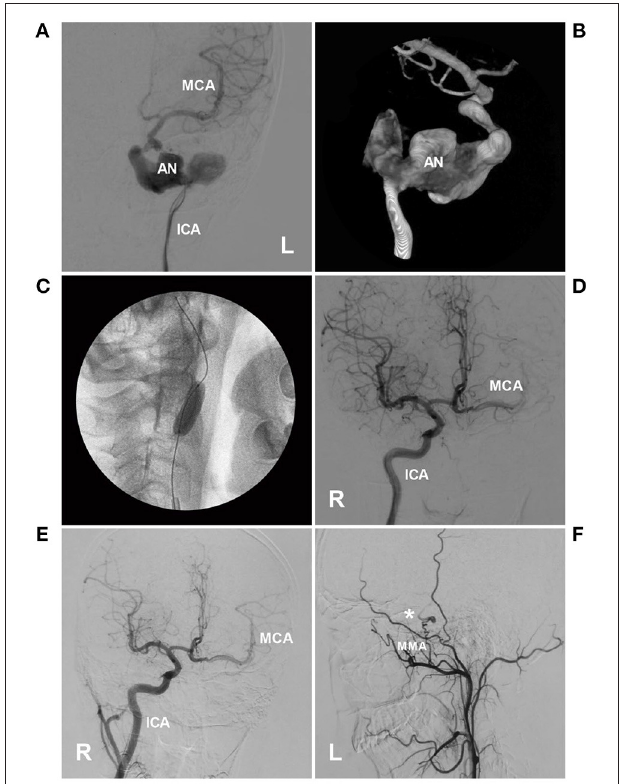
FIGURE 4 | PAO of the ICA for a giant petrous segment aneurysm. (A,B) Left DSA (A) and three-dimensional DSA (B) showed an unregular giant aneurysm (AN) on the petrous segment of the ICA. (C) X-ray film showed that the BOT was performed, and the balloon was located in the ICA under the aneurysm. (D) During the BOT, DSA of the right ICA showed collateral circulation through the AcomA to the left MCA. (E) After PAO of the left ICA, 1-year follow-up DSA showed that collateral circulation through the AcomA was sufficient. (F) The external carotid artery showed anastomosis between the MMA (asterisk) and intracranial pial artery. AcomA, anterior communicating artery; BOT, balloon occlusion test; DSA, digital subtraction angiography; ICA, internal carotid artery; L, left; MCA, middle cerebral artery; MMA, middle meningeal artery; PAO, parent artery occlusion; VA, vertebral artery.